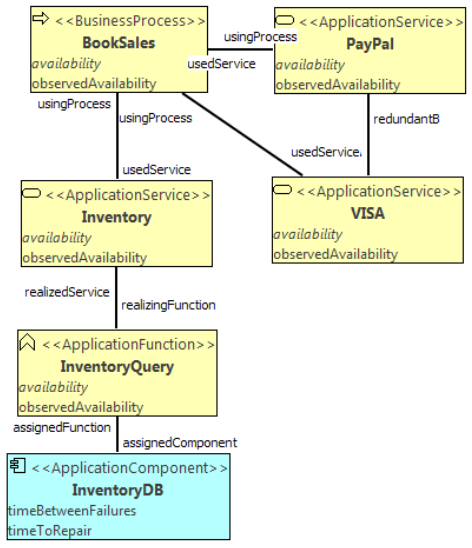
Figure 3. A simple MAPL availability